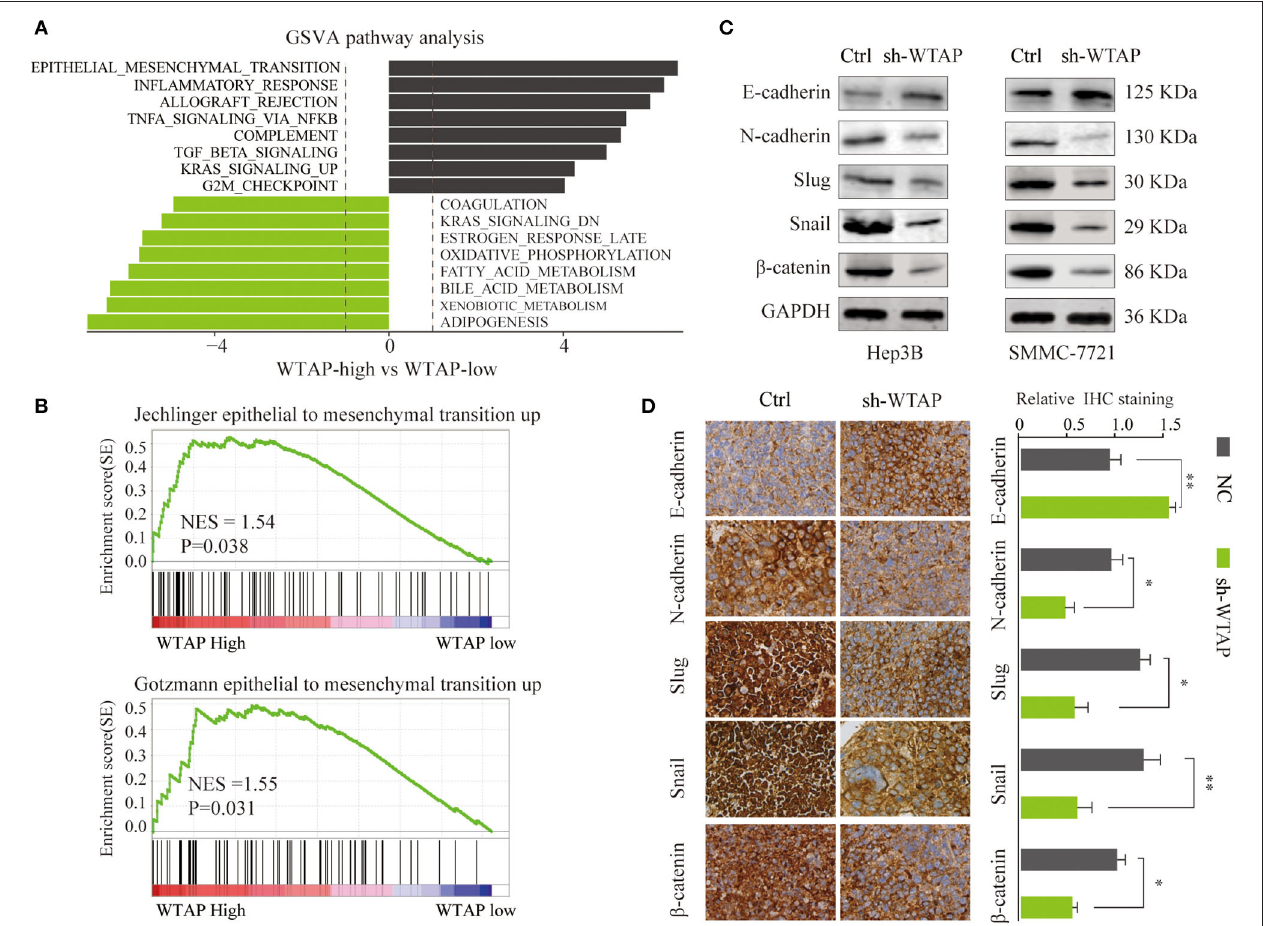
FIGURE 5 | WTAP promotes the epithelial–mesenchymal transition (EMT) in HCC. (A) Gene set variation analysis (GSVA) of the signaling pathways in tumors with a high or low WTAP expression in the TCGA HCC database. (B) GSEA of a correlation between the WTAP expression and EMT-related gene signatures in HCC. (C) A western blot analysis of the protein levels of EMT-related proteins in Hep3B or SMMC-7721 cells transfected with sh-WTAP or controls. GAPDH was used as a loading control. (D) IHC staining of E-cadherin, N-cadherin, Slug, Snail, and β -catenin in the tumor tissues from the NC or sh-WTAP group. Scale bar, 100 µ m. * p < 0.05, ** p <